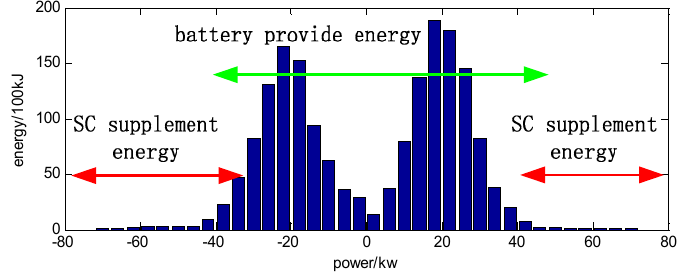
Figure 20. Power distribution of the SC/battery HESS.